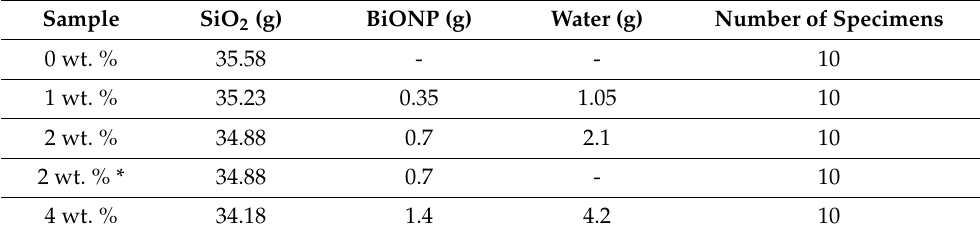
Table 1. Number of specimens and content of inorganic elements. The asterisk indicates that the sample was obtained without using